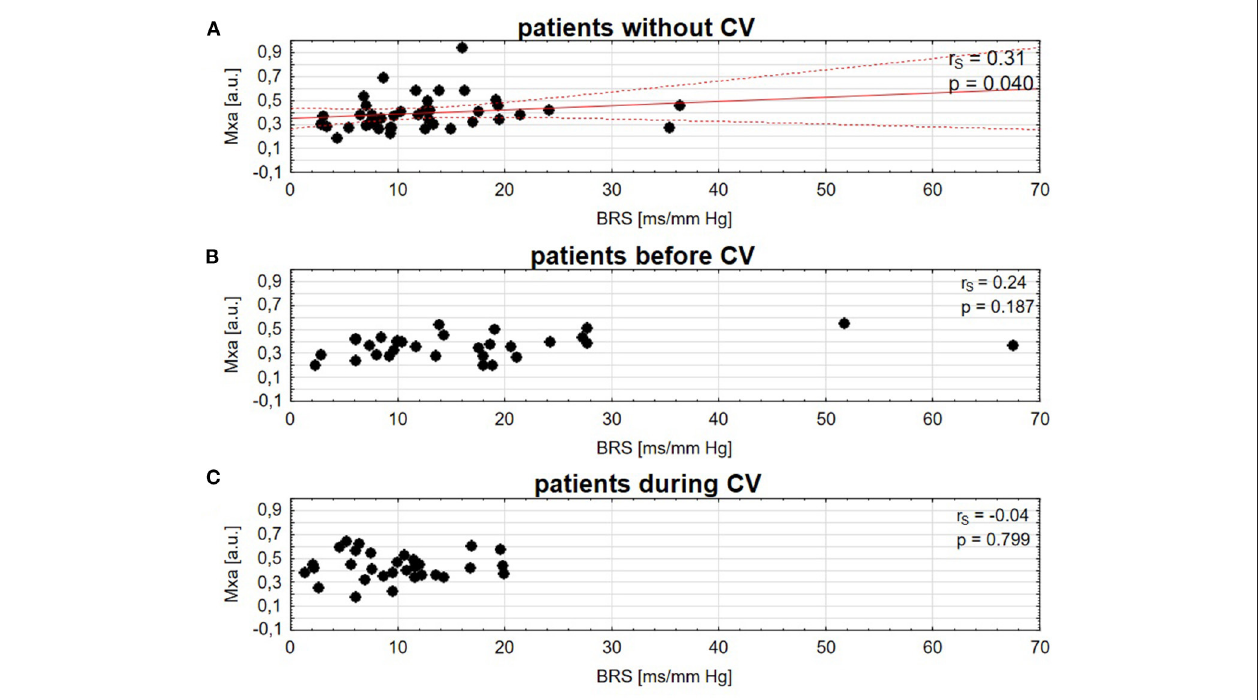
FIGURE 3 | Spearman correlation of cerebral autoregulation (Mxa) and baroreflex sensitivity (BRS) in patients (A) , without cerebral vasospasm (CV), (B) before CV, (C) during CV. A solid red line is a linear regression and dashed lines represent 95%